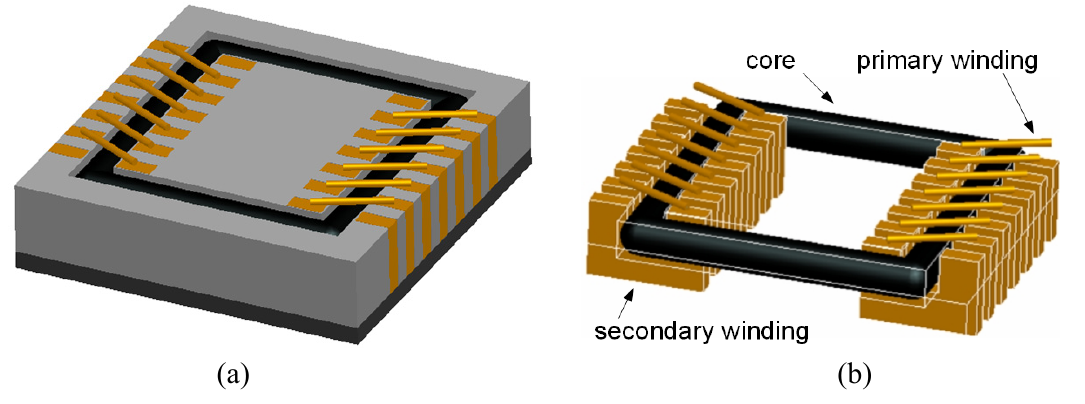
Figure 6. The schematic diagram of solenoid type transformer: (a) the whole structure; (b) the perspective